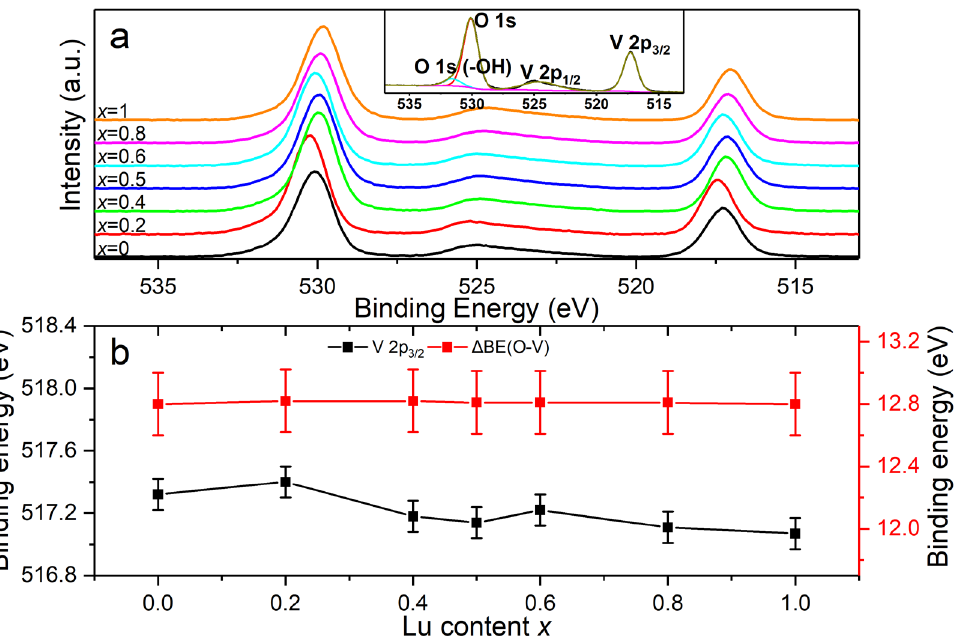
Figure 8. ( a ) Stacked O 1 s and V 2 p XPS spectra of Lu x Gd 1 − x VO 4 ( 0 ≤ x ≤ 1) and the deconvoluted spectrum of GdVO 4 (inset). ( b ) Binding energy of V 2 p 3/2 and binding energy difference between O 1 s and V 2 p 3/2 versus the Lu content x . The error bars are 0.1 and 0.2 eV, respectively.